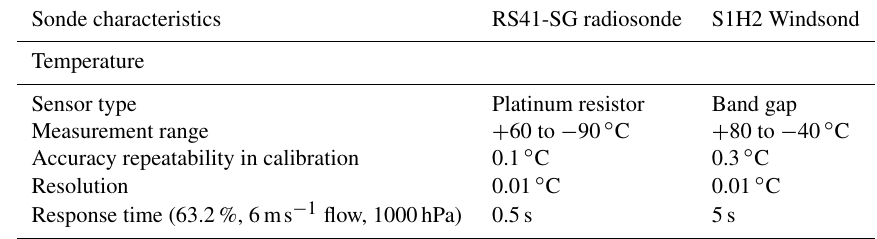
Table 2. Sonde temperature sensor manufacturer specifications (based on Table 1 from Vaisala, 2014; SparvEmbedded, 2016).